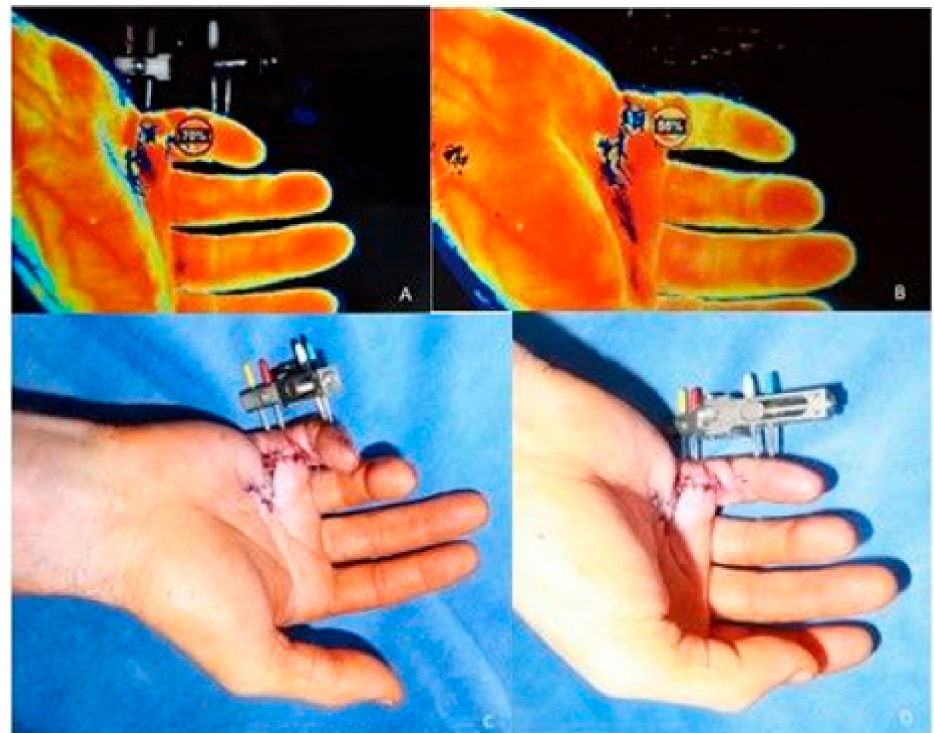
Figure 3. Hyperspectral imaging showing malperfusion (yellow parts) after extension subfigure ( B ) in comparison to the non-extended finger subfigure ( A ). Red color represents well-perfused skin, as measured with the no-contact hyperspectral imaging device, consistently distributed over the visible palm of the hand. A change in optimal oxygen saturation (red = 100% oxygen saturation) is shown as yellow, representing decreasing amounts of oxygen saturation. Under distraction, more yellow can be observed in the right depiction ( B ). Corresponding clinical images of the non-extended ( C ) and extended finger ( D